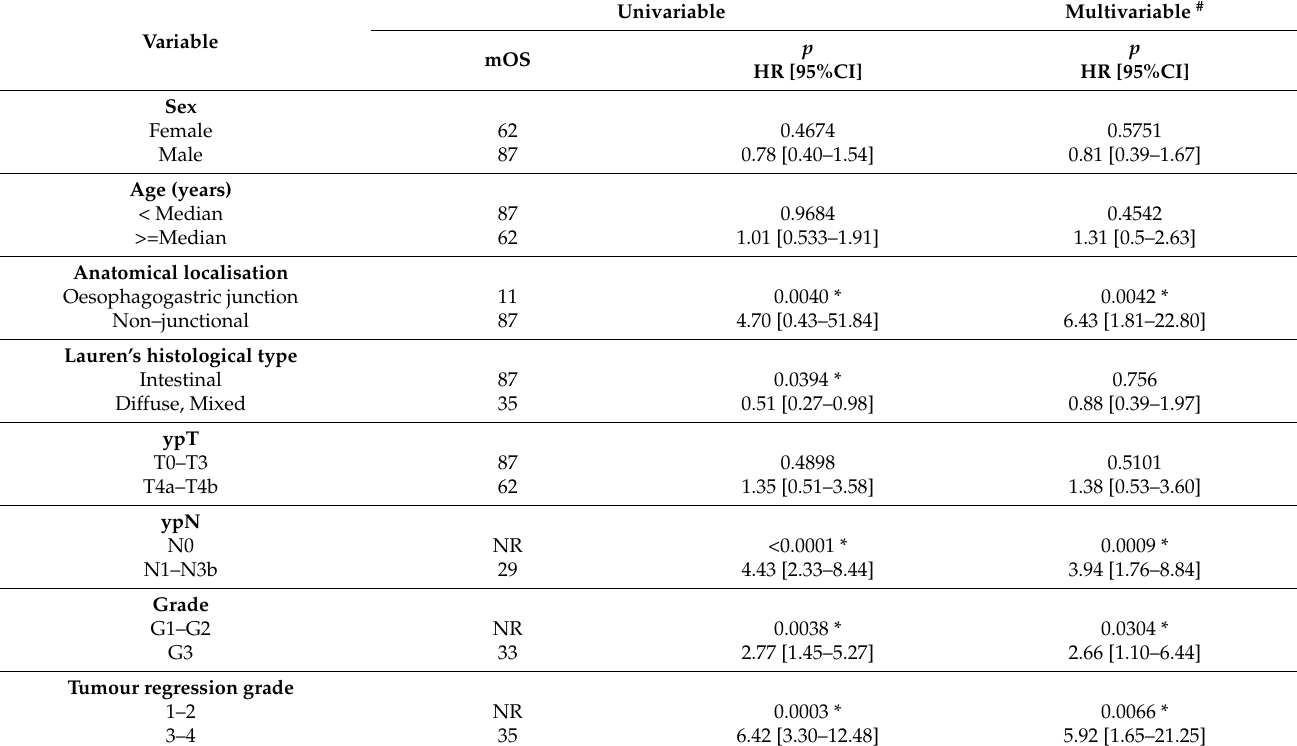
Table 3. Influence of selected demographic and clinical variables on overall